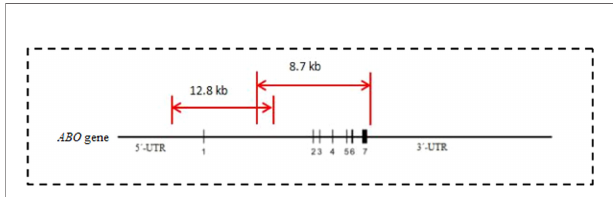
FIGURE 1 | Amplify the sequence of the ABO gene by LR-PCR technology. Two pairs of primers with the coverage from 5 ’ -UTR to 3 ’ -UTR of the ABO gene were designed. Two overlap amplicons with the length of 12.8 kb and 8.7 kb were ampli fi ed respectively. The schematic drawing of ABO gene cited from